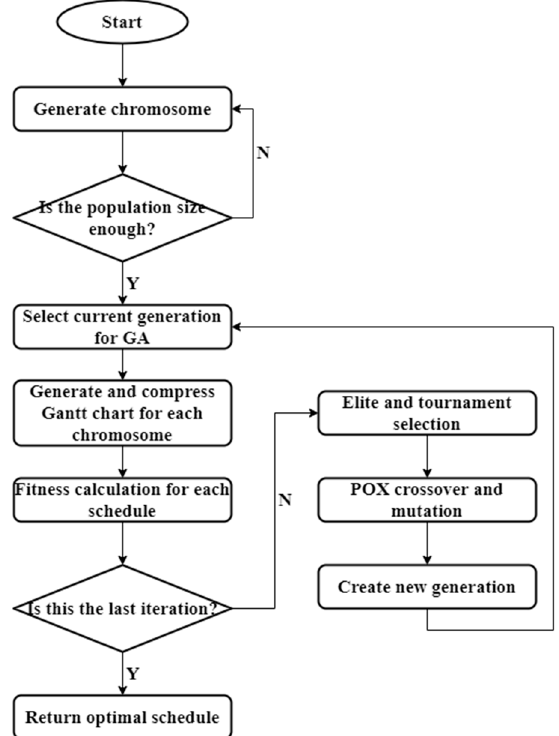
Figure 6. Flowchart of the GA-based TSN optimal schedule method.